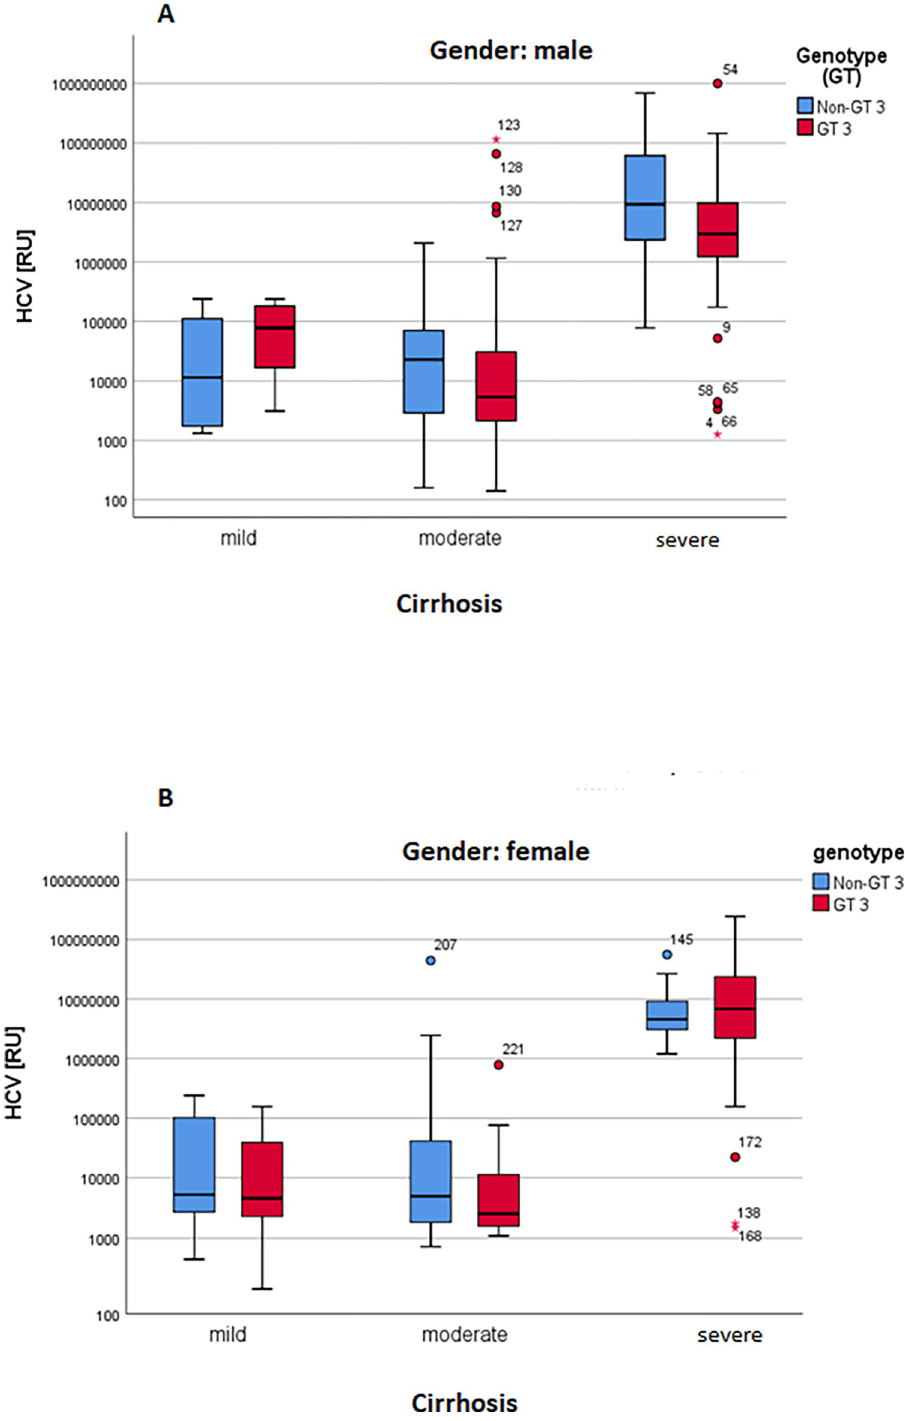
Fig 9. A, B: Grouped boxplot of viral load steps: cirrhosis and genotypes.